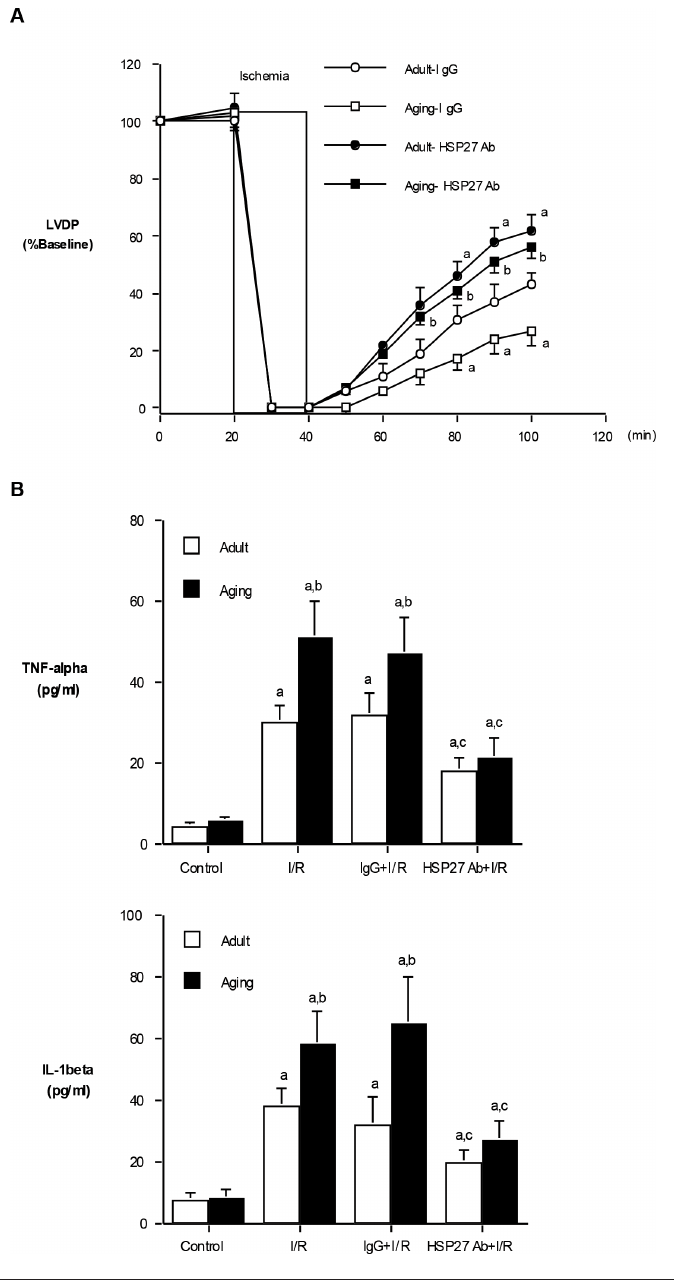
Figure 2. Extracellular HSP27 mediates postischemic inflammatory response and func- tional injury in aging hearts. Hearts from adult and aging mice were subjected to global ischemia/reperfusion (I/R: I 20 min/R 60 min). Hearts were treated with a polyclonal anti- body against heat shock protein 27 (HSP27 Ab, 1.0 μ g/mL) or control IgG (IgG, 1.0 μ g/mL) for 10 min before ischemia and for 20 min after initiation of reperfusion. A) Anti-HSP27 improved cardiac functional recovery in both adult and aging hearts, but had a greater effect in aging hearts. Data are expressed as mean ± SE. n = 7; a P < 0.05 versus adult IgG + I/R; b P < 0.05 versus aging IgG + I/R. B) Anti-HSP27 reduced myocardial cytokine levels in adult and aging, and the effect was greater in aging hearts. Data are expressed as mean ± SE. n = 7; a P < 0.05 versus age-matched control; b P < 0.05 VS. adult I/R or IgG + I/R; c P < 0.05 versus age-matched IgG +